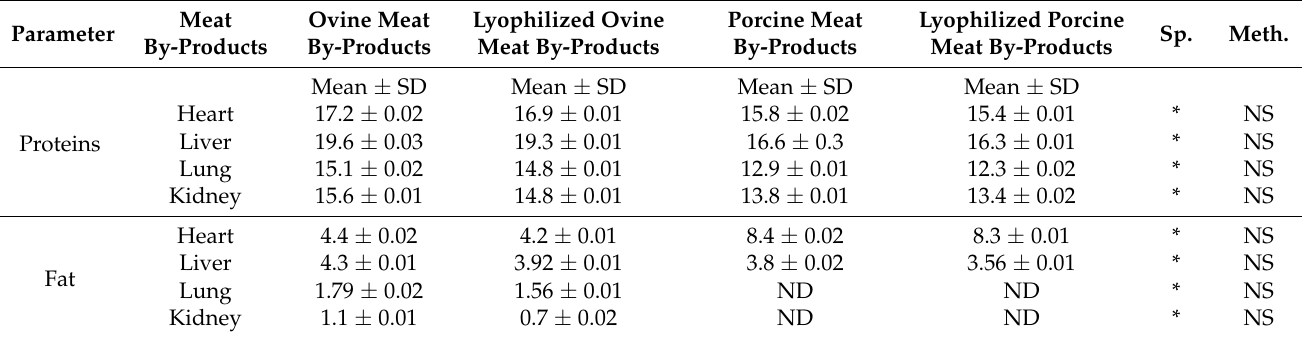
Table 1. Protein and fat content in raw and lyophilized meat by-products